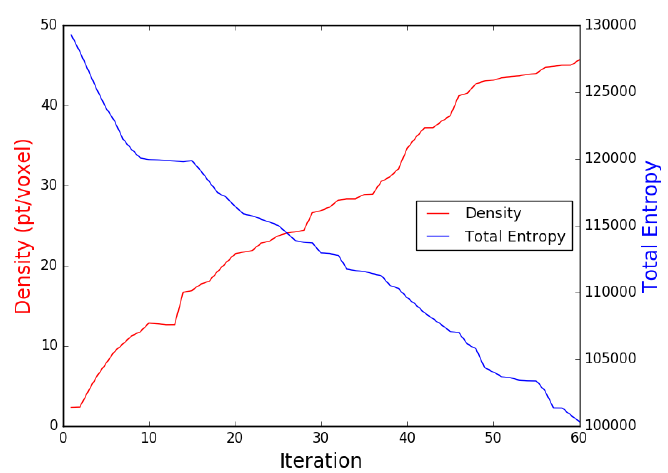
Figure 17. The density and total entropy attributes along the iterations during the indoor real experiment for the airplane model.